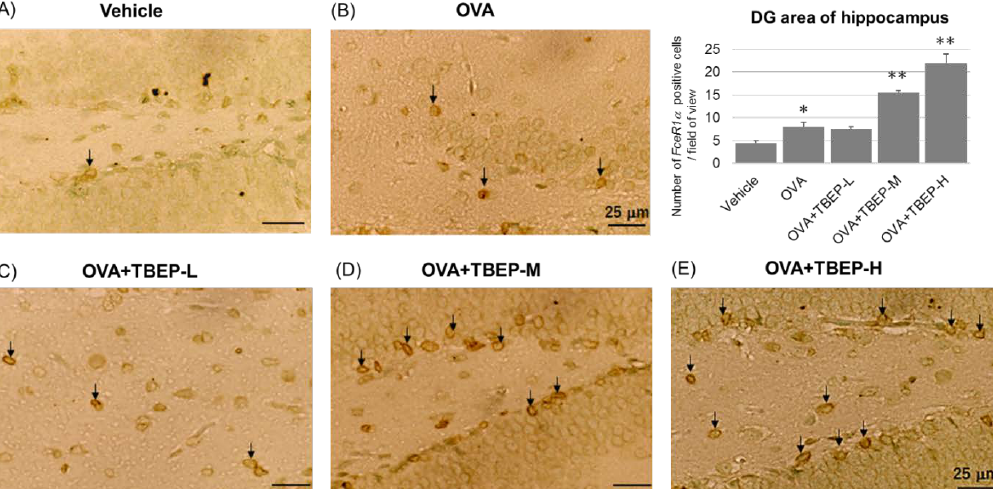
Figure 9. Immunohistochemical analysis of Fc ε R1 α (mast cell marker) of the dentate gyrus of the hippocampus. Fc ε R1 α -positive mast cells in ( A ) vehicle, ( B ) OVA, ( C ) OVA + TBEP-L, ( D ) OVA + TBEP-M and ( E ) OVA + TBEP-H. Black arrows indicate Fc ε R1 α -positive mast cells. (Scale bar = 25 µ m). Number of Fc ε R1 α -positive cells located within the DG area of the hippocampus was quantified in a high power field under microscopy (histogram). (n = 2, * p < 0.05, ** p < 0.01 vs. vehicle